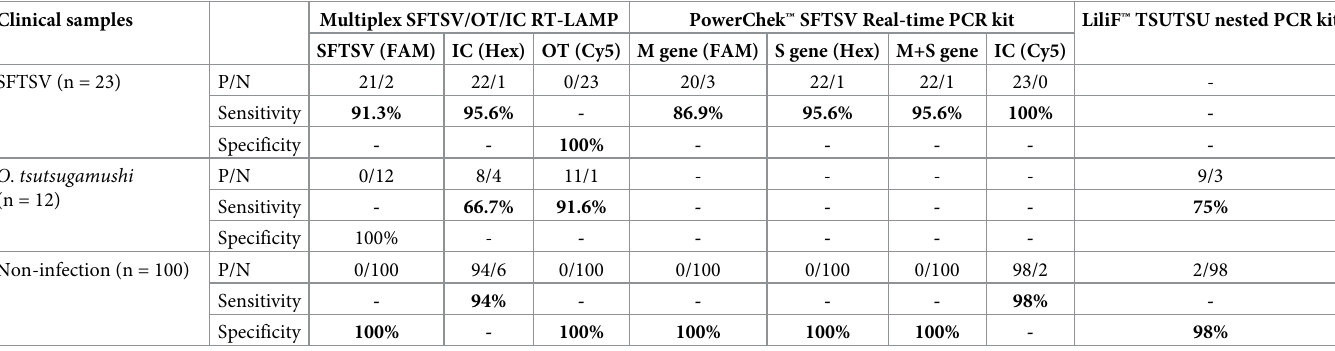
Table 4. Comparison of clinical performance between the multiplex SFTSV/OT/IC RT-LAMP assay, PowerChek ™ SFTSV Real-time PCR kit, and LiliF ™ TSUTSU nested PCR kit for clinical samples from patients infected with SFTSV or O . tsutsugamushi . Clinical